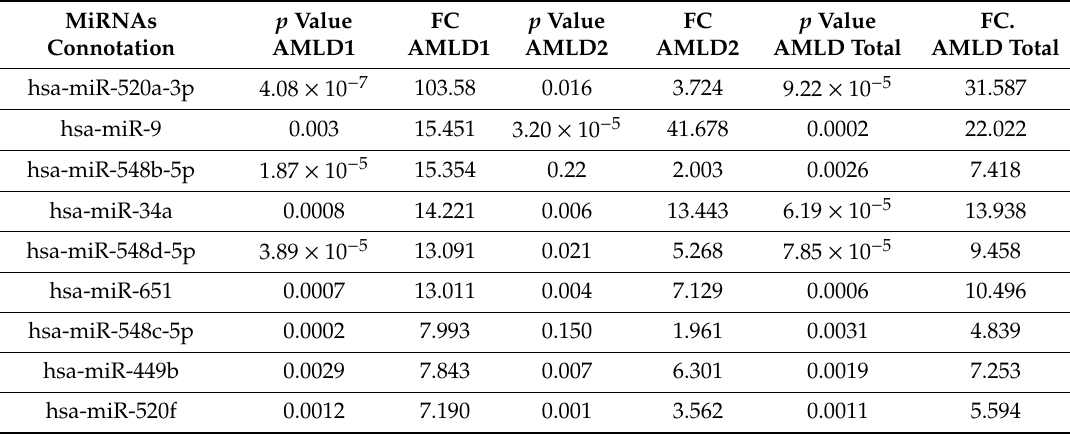
Table 2. Confirmed differentially expressed microRNAs between AML patients and HD in a second cohort.